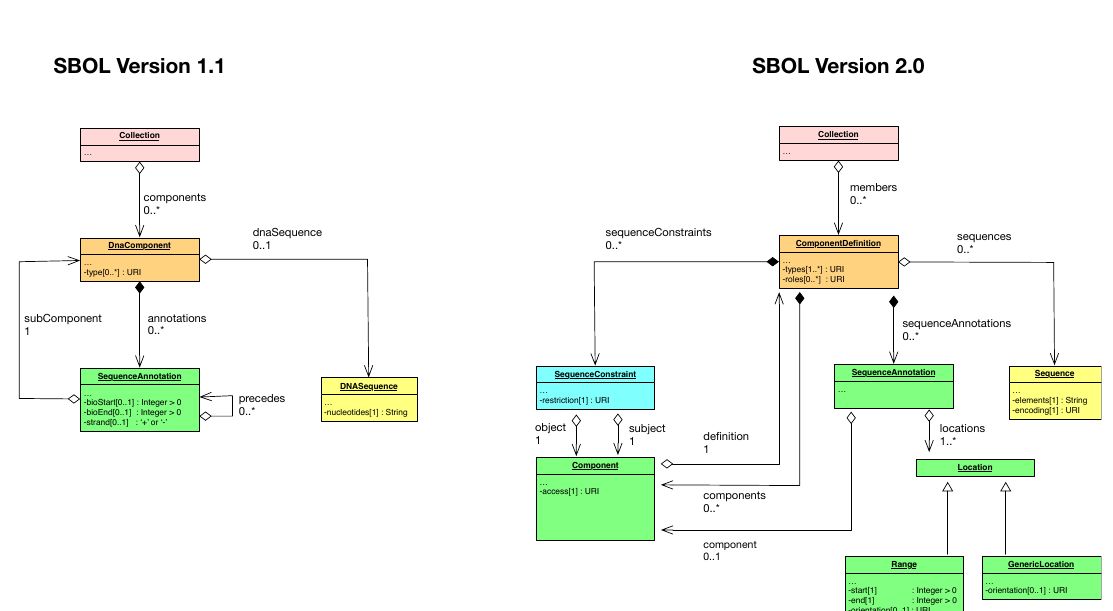
Figure 25: The mapping from the SBOL 1.1 data model to the SBOL 2.x data model, indicating corresponding classes/properties by